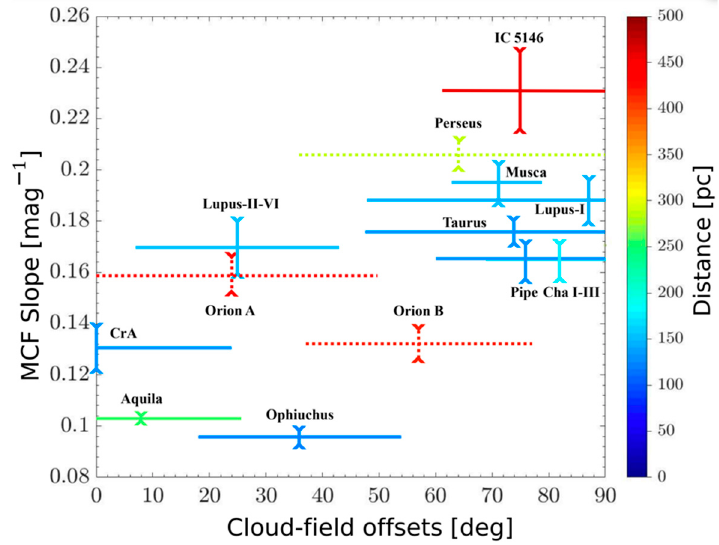
Figure 9. MCF slopes vs. cloud-field orientation offsets. Each symbol is color coded by the cloud distance (to show that resolution is not the cause of the trend). The cloud-field orientation offsets and the interquartile ranges (not the errors of the means) are adopted from [35]. The MCF uncertainties (vertical error bars) were defined in [34]. Perseus and Orion A/B (dotted lines) have more extensive line-of-sight scales and the largest discrepancies between the B-field directions inferred from Planck and optical data (Figure 6). The statistical tests summarized in Figure-7 caption were also performed here for a significant positive correlation [34].